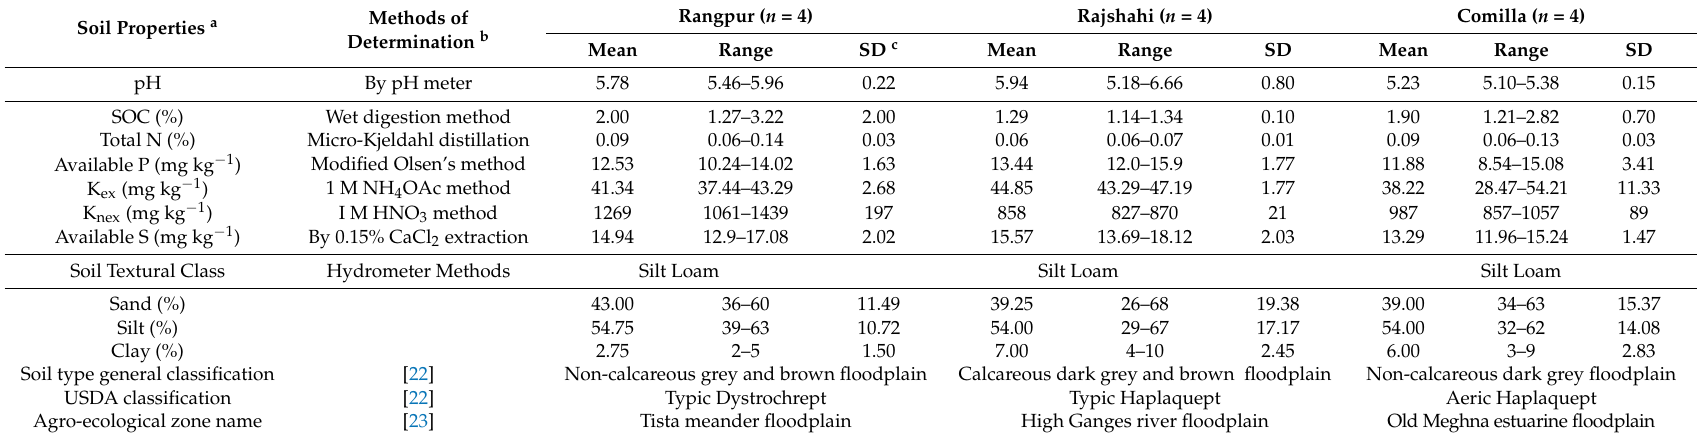
Table 2. Chemical and physical properties of four soil samples for each field experimental site (Rangpur, Rajshahi and Comilla) before sowing of rabi (winter) maize,